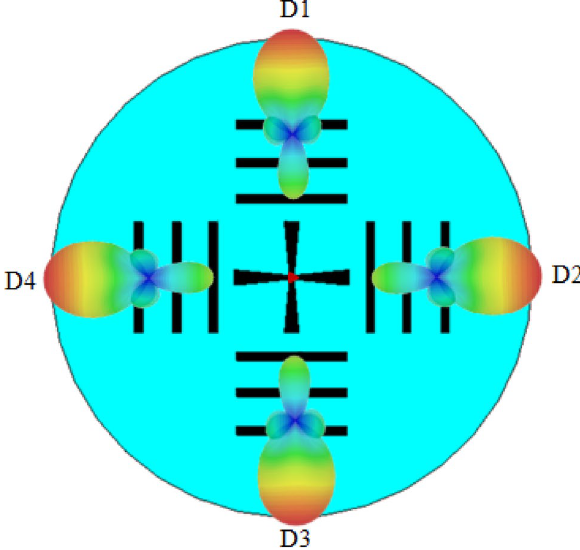
Figure 3. Four working modes of the graphene THz antenna.